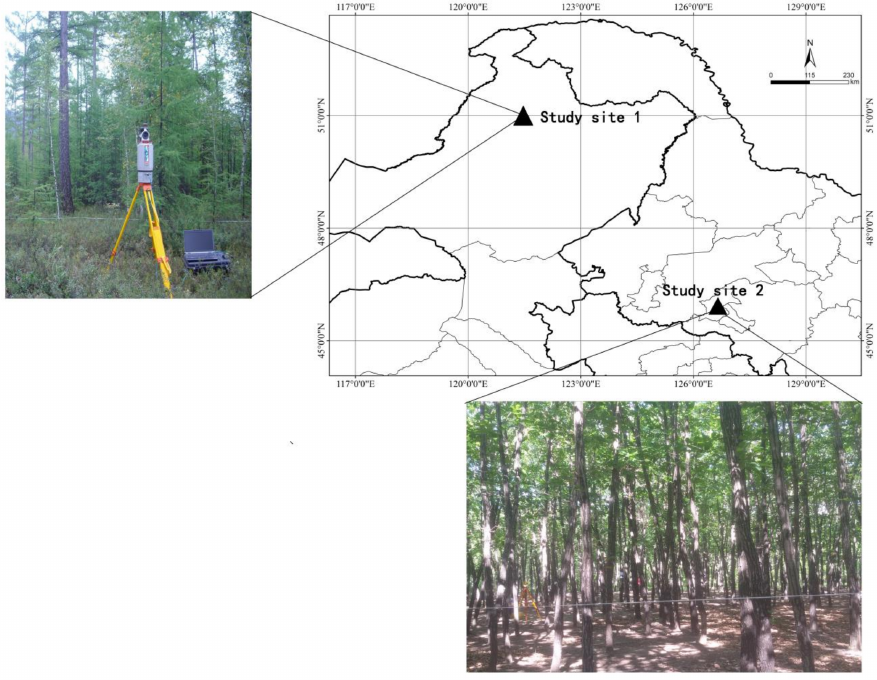
Figure 1. Location of the study